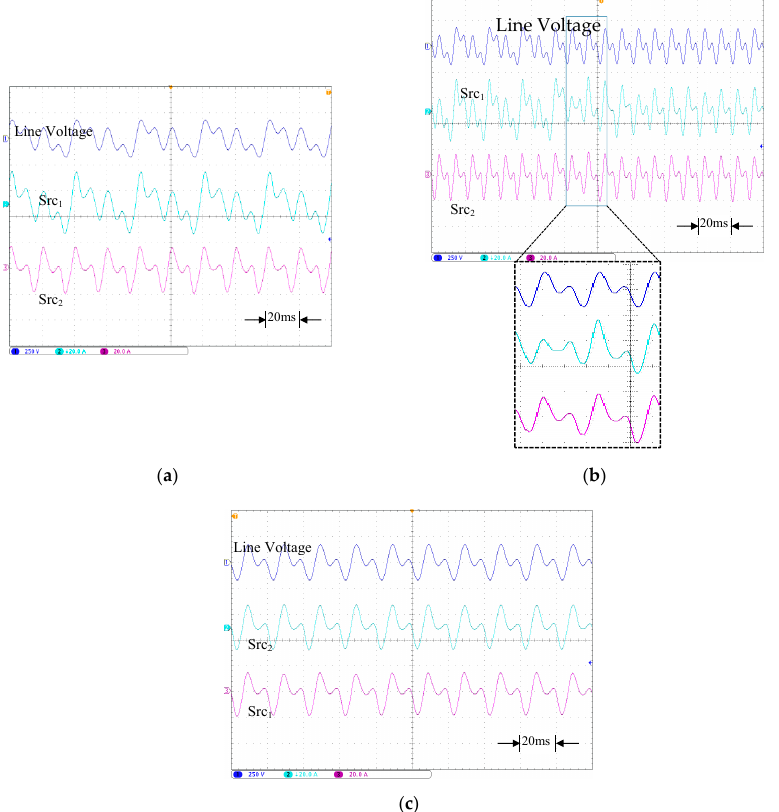
Figure 11. Experimental study sources behavior in multi-channel power system after grid disconnection where one sources supply power to all channels while the other supplies power merely to critical loads on non-grid supplied channels; ( a ) Src1 feeding power in ch2 and ch3 and Src2 feeding power over all three channels; ( b ) Grid disconnection casuing elimination of ch1, ( c ) Src1 and Src2 output currents after grid